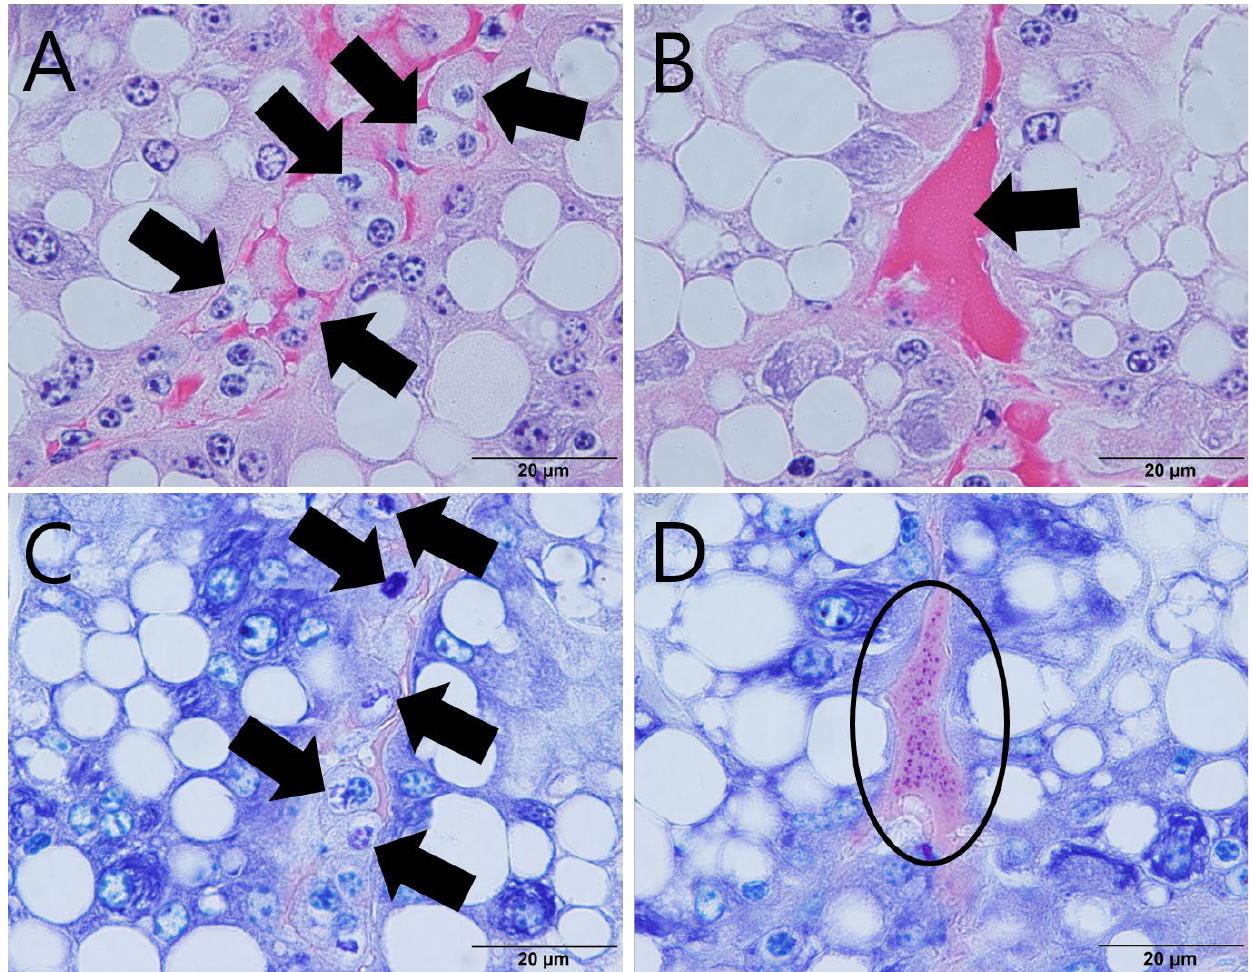
Figure 2. Hepatopancreas in giant freshwater prawn ( Macrobrachium rosenbergii ) infected with EHP. H&E staining revealed: ( A ) plasmodium of EHP in epithelial cells of hepatopancreas (arrows) and ( B ) sinus between epithelial cells of digestive tubule filled with eosinophilic fluid (arrow). Giemsa staining revealed: ( C ) plasmodium of EHP in epithelial cells of hepatopancreas (arrows) and ( D ) multiple mature EHPs ranging from 0.8 to 1 µm in sinus (ellipse).